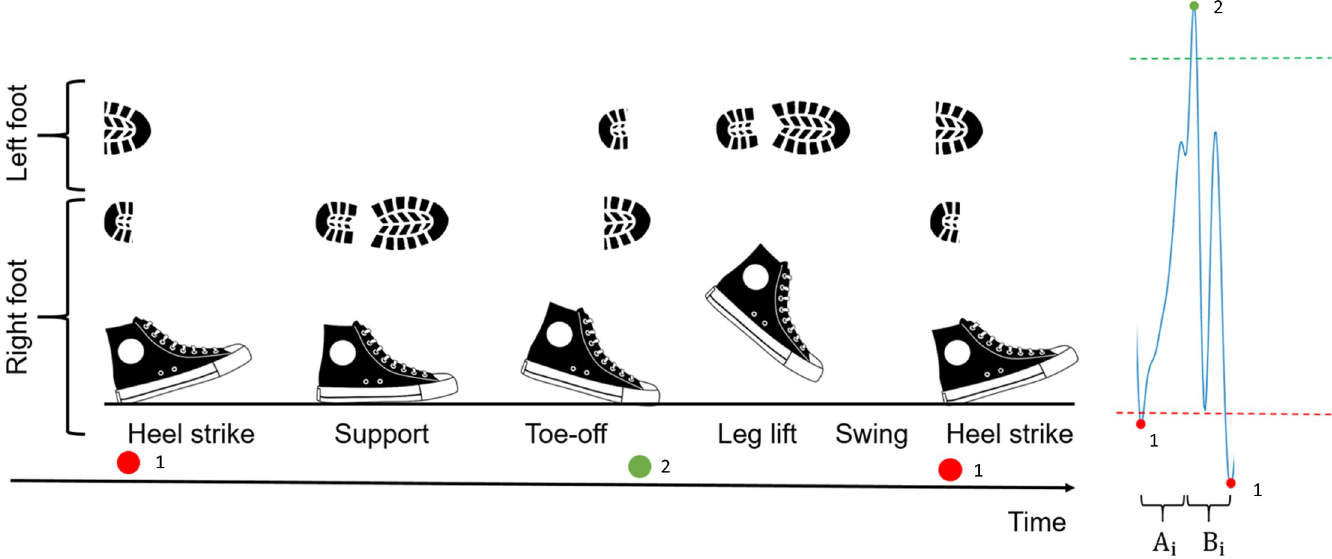
Fig 5. One step cycle from a filtered accelerometer signal in the vertical direction (from heel strike to heel strike). The peaks (green dot) and troughs (red dots) were identified as the local maxima and minima above and below a threshold, respectively. Thresholds are indicated by the green and red dotted lines. Two segments, A i and B i were measured for each step i . A denotes the time from the beginning of a heel strike to a toe-off. B denotes the time from the toe-off to the next heel strike. https://doi.org/10.1371/journal.pone.0236258.g005 PLOS ONE | https://doi.org/10.1371/journal.pone.0236258 July 23,